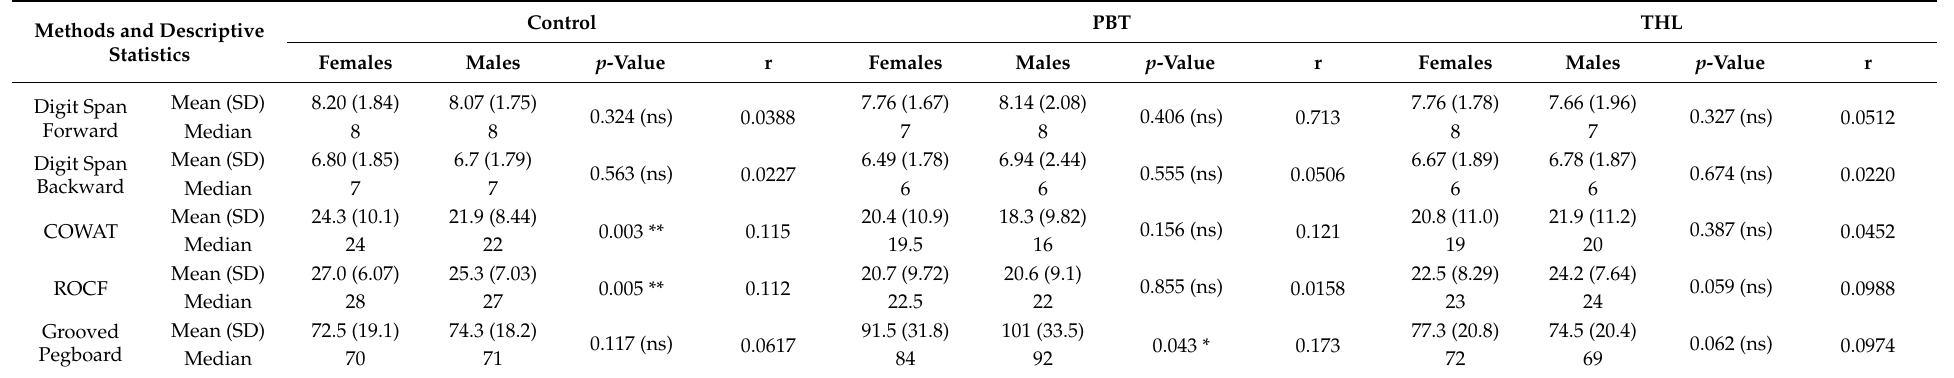
Table 3. Mean group comparisons of neurocognitive performance between females and males among healthy controls ( n /females = 336; n /males = 310), pediatric brain tumor ( n /females = 72; n /males = 65) and hematopoietic and lymphoid tissues tumor survivors ( n /females = 168; n / males =